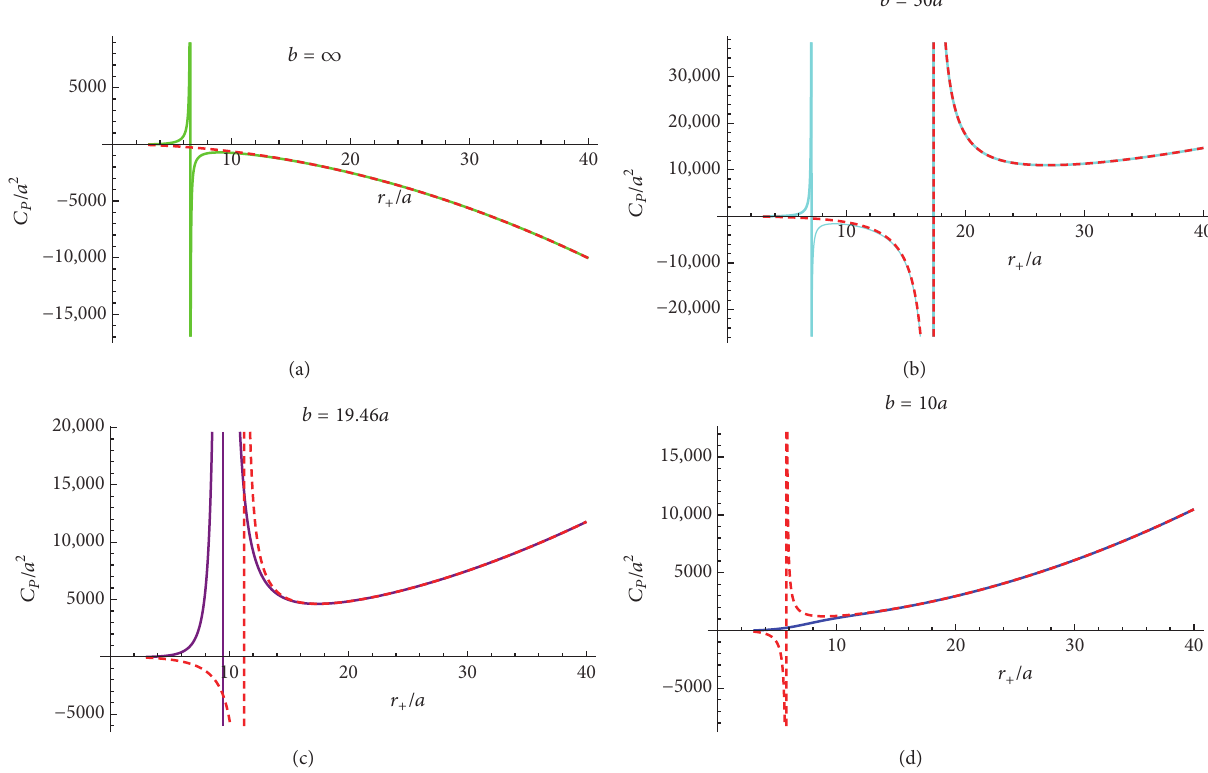
Figure 8: Plots of the heat capacity 𝐶 𝑃 with respect to 𝑟 + under different pressure. They correspond to 𝑏/𝑎 → ∞ (a), 𝑏/𝑎 = 30 (b), 𝑏/𝑎 = 19.46 (the critical vacuum pressure (c)), and 𝑏/𝑎 = 10 (d), respectively. The solid curves correspond to (18), and the dashed red curves correspond to the relationship 𝐶 𝑃 = 2𝜋𝑟 2 + (𝑏 2 + 3𝑟 2 + )/(3𝑟 2 + − 𝑏 2 ) of the ordinary Schwarzschild-AdS situation.